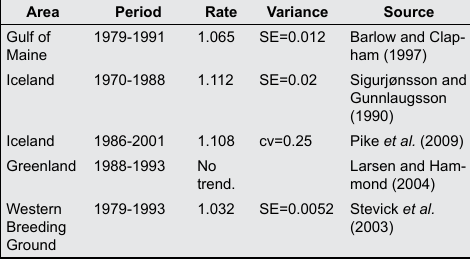
Table 2. Rates of increase observed on humpback whale breeding and feeding grounds in the North Atlantic, from published